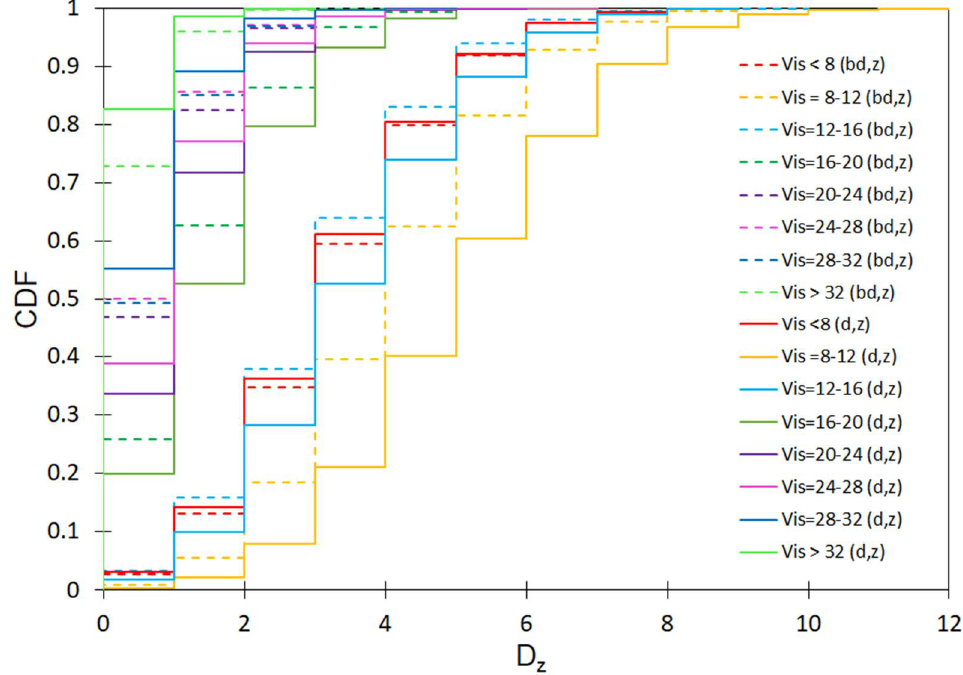
Figure A2. Number of days (D z ) with visibility in the respective range of variability for the period rain and no rain for the spring season.